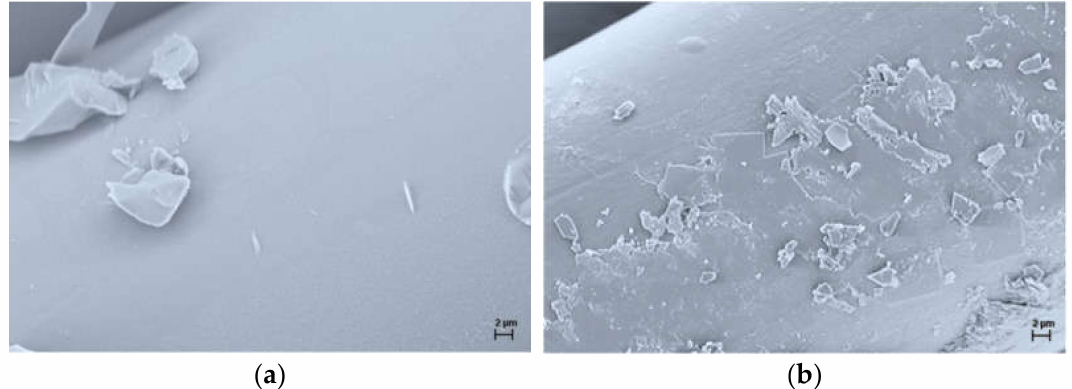
Figure 5. Representative SEM images of the surface morphology of the PA6/15PHED fibers after incubation of E. coli (( a ) at magnification factor/working distance of 5000 × /4.2 mm) and S. Aureus , (( b ) at magnification factor/working distance of 5000 × /4.1